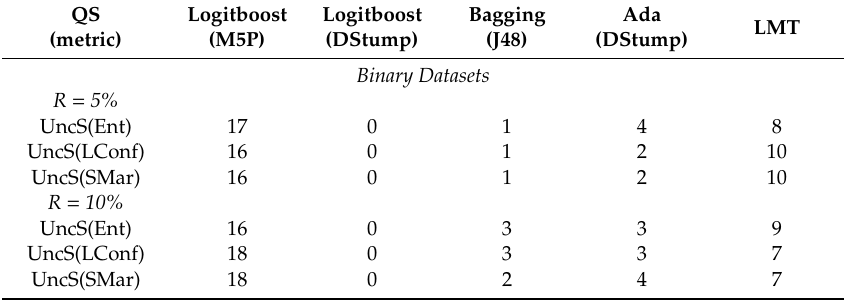
Table 8. The number of best achieved performance over the examined datasets per base learner for the included query strategies and R-based experiments compared to ensemble